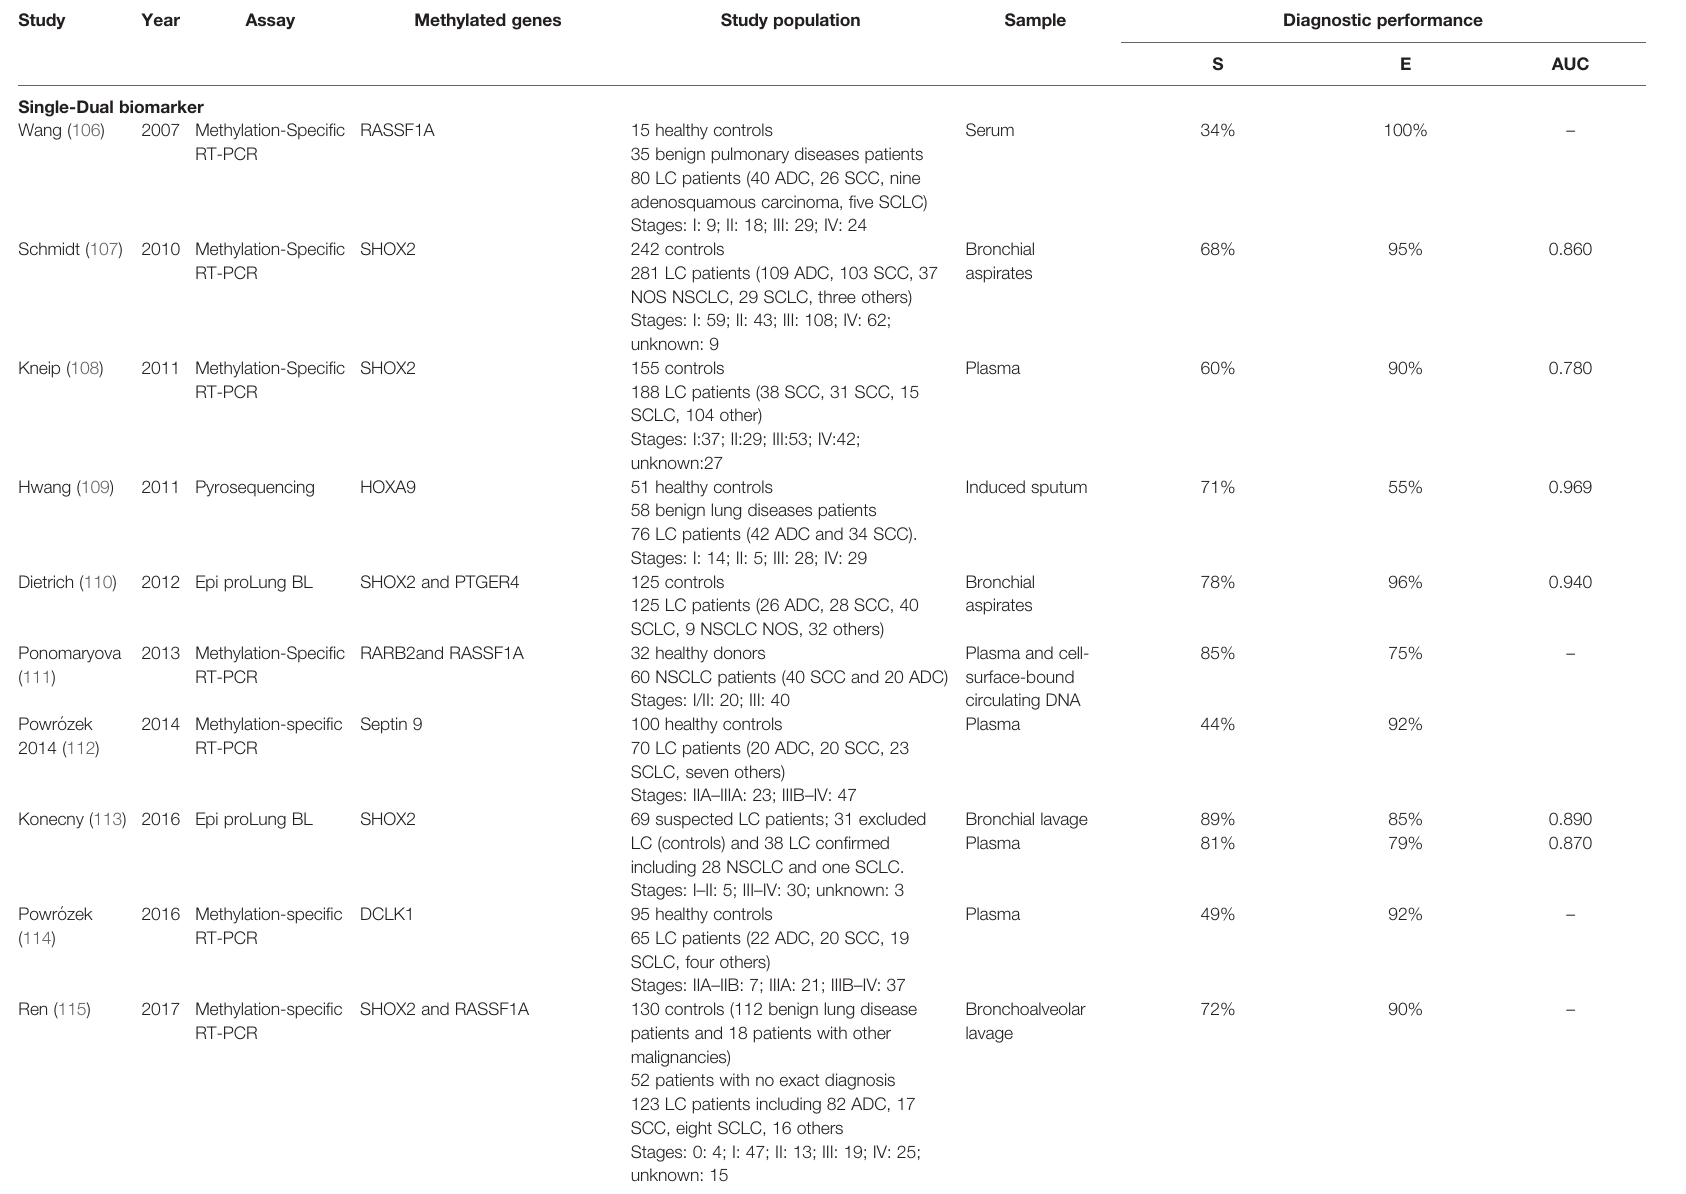
TABLE 4 | cfDNA hypermethylation performance as biomarker for lung cancer